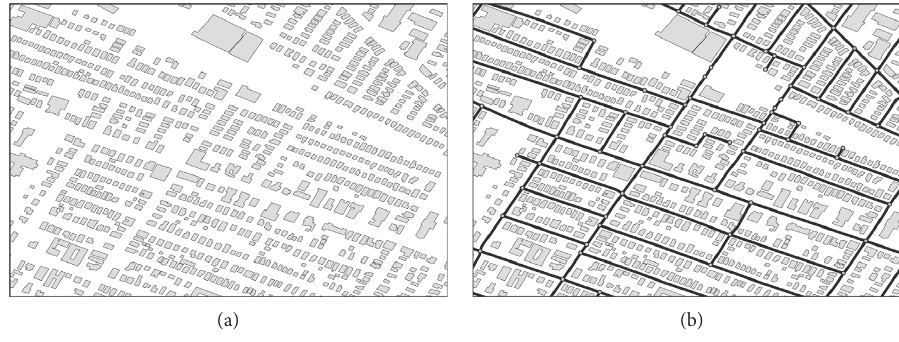
Figure 1: The single-layer network representation